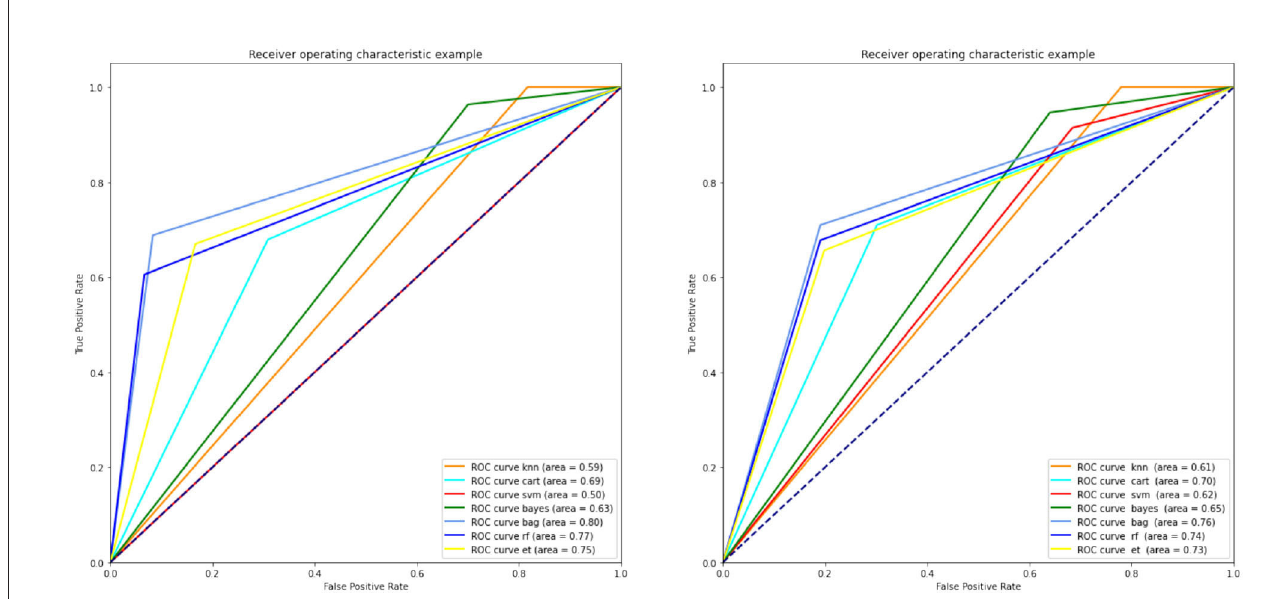
FIGURE 5 | ROC curves of conventional ML classifiers. ML, machine language; ROC, receiver operating